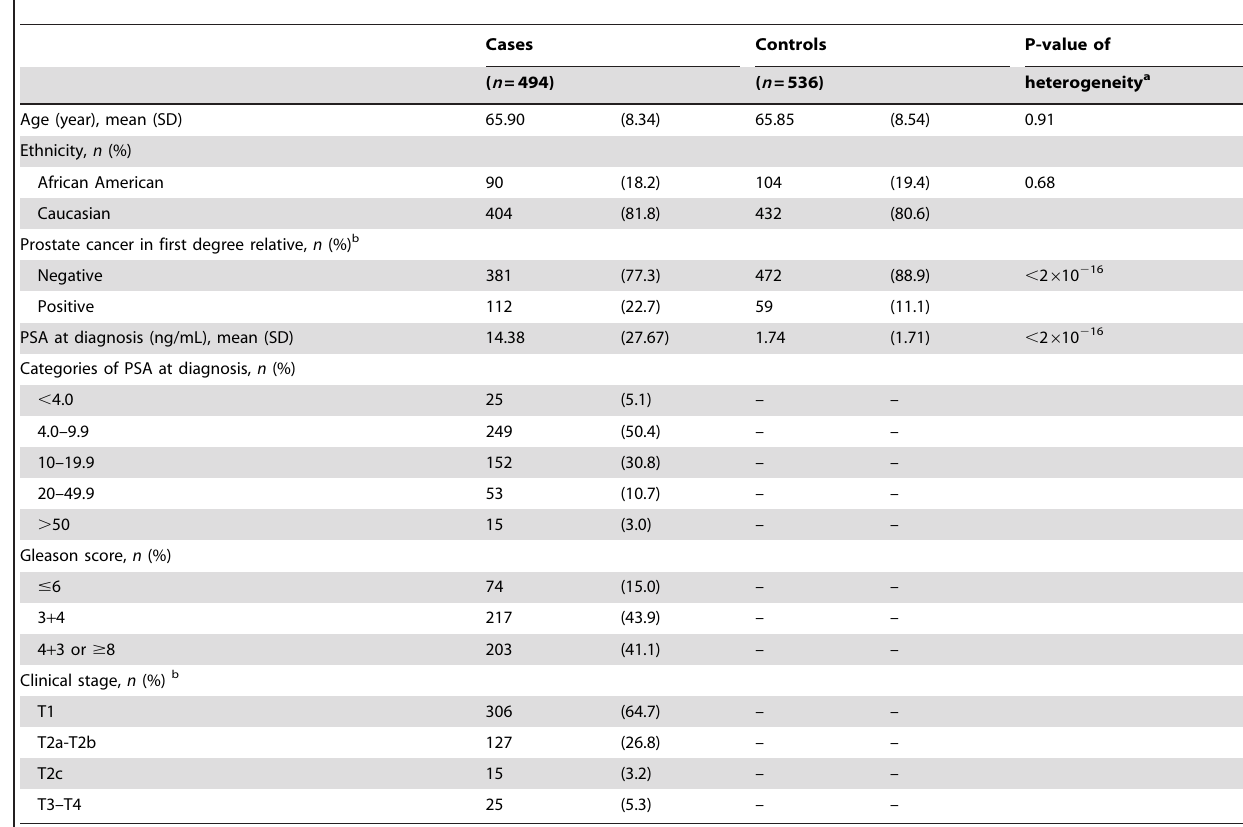
Table 1. Study characteristics of the advanced prostate cancer cases and